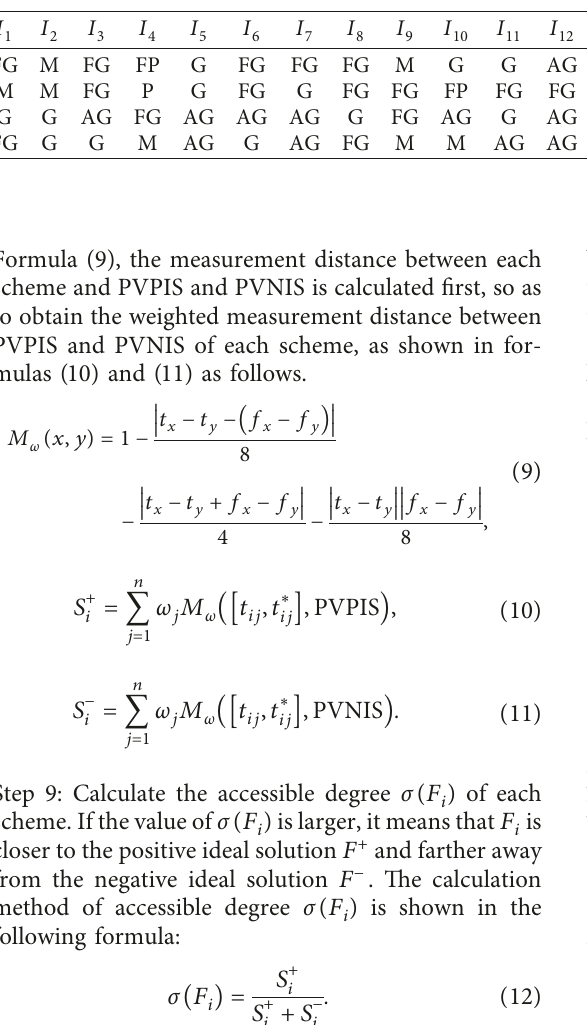
Table 2: Language scores for each scheme